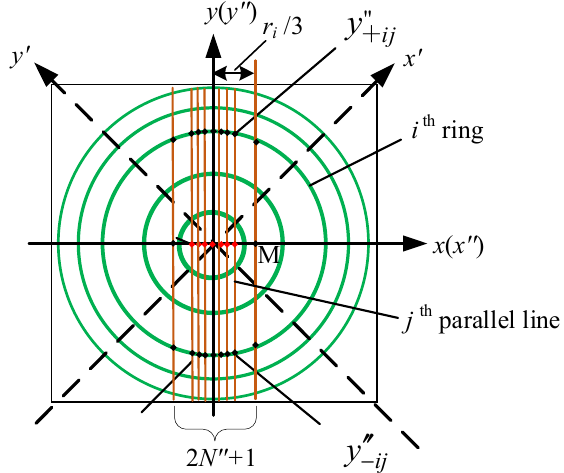
′′ . Figure 7. Multiple ring peak coordinates under line segments N